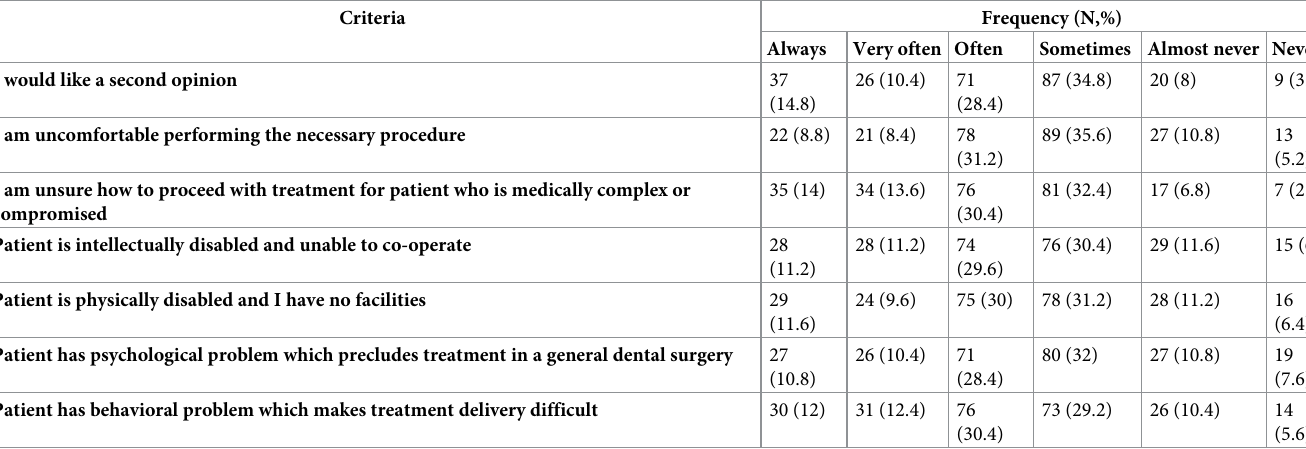
Table 5. Distribution of special care patient referral